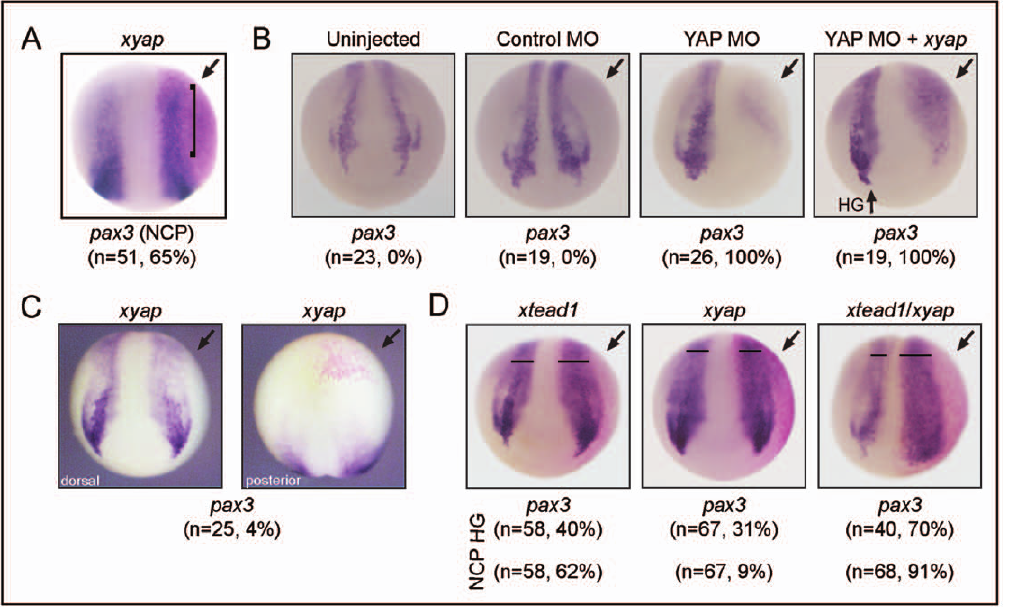
Figure 6. xYAP expands pax3 -expressing neural crest progenitors. ( A ) The pax3 -expressing neural crest progenitor field (NCP) is darker, longer, and/or wider (bracket) on the xyap -injected side. Dorsal view, stage 15. ( B ) xYAP MO-mediated knockdown (40 ng) eliminated pax3 expression in both neural crest progenitors and hatching gland (HG) precursors. Addition of exogenous xyap (YAP MO + xyap ) rescued pax3 expression in neural crest progenitors (NCP), but not in hatching gland. Dorsal views, stage 17. ( C ) xyap mRNA injection into the precursor blastomere of the intermediate mesoderm does not cause pax3 expansion on the injected side (left panel, dorsal view). Right panel (posterior view, dorsal is down) shows part of the lineage labeled clone (red) denoting the injected side. ( D ) tead1 mRNA injection (100 pg) expands pax3 -expressing neural crest progenitors (NCP) at a moderate frequency. xyap mRNA injection (100 pg) rarely expands this population. In combination ( tead1 / xyap , 100 pg each), this population is expanded in nearly every embryo. The repression of the pax3 -expressing hatching gland progenitors (HG) also was greatest when TEAD/xYAP were co-expressed. Dorsal anterior views at stage 16.